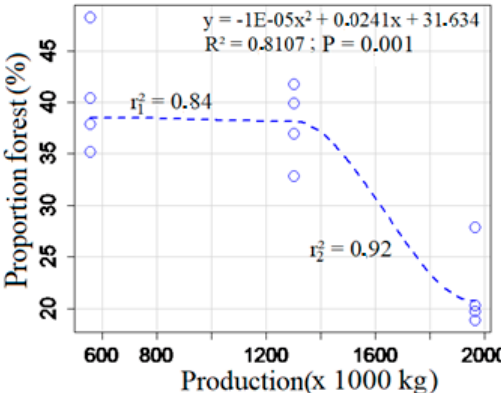
Figure 6. Relationship between national production and proportion of forest from 1985–1986 to 2018–2019.